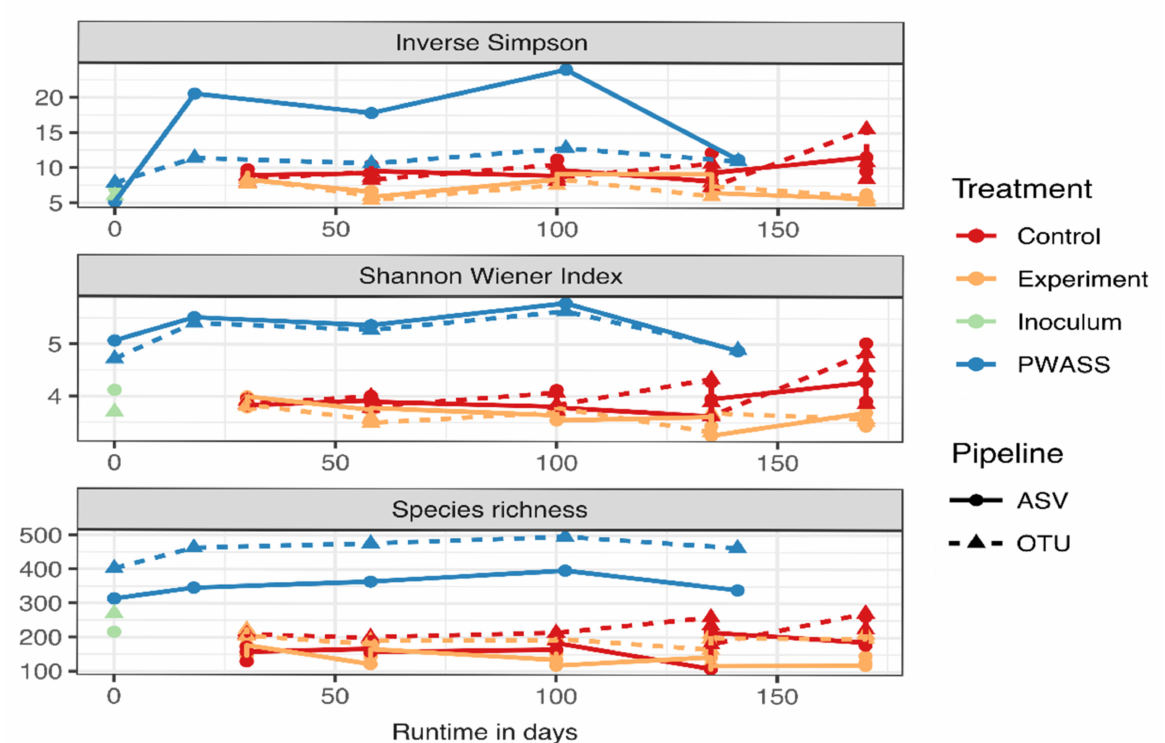
Figure 1. Comparison of the two pipelines for observed α -diversity over time, expressed via a set of different α -diversity indices. Sample types, i.e., treatments, are represented with color-coding, while pipelines are represented by differing symbols, and dashed and solid